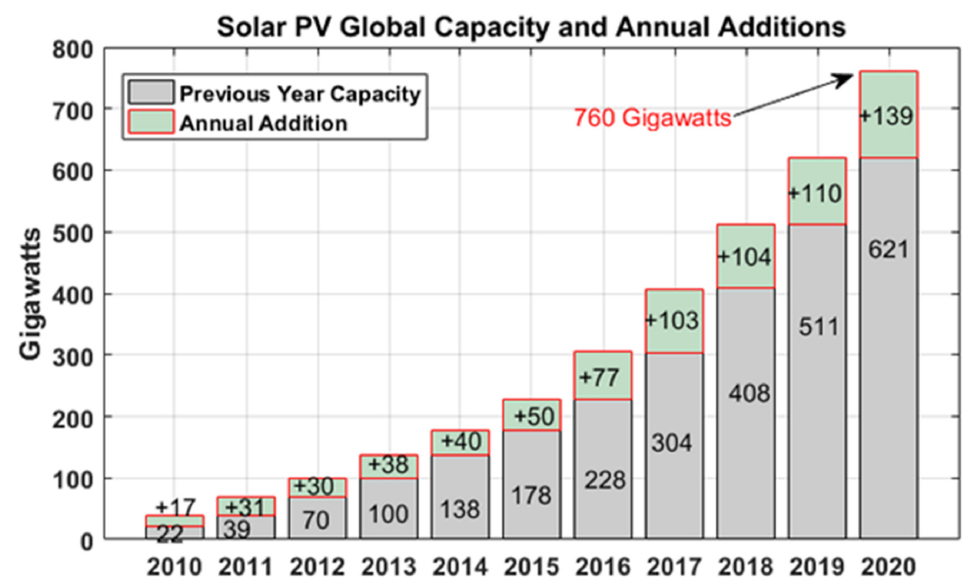
Figure 1. Status of renewable sources installations worldwide.